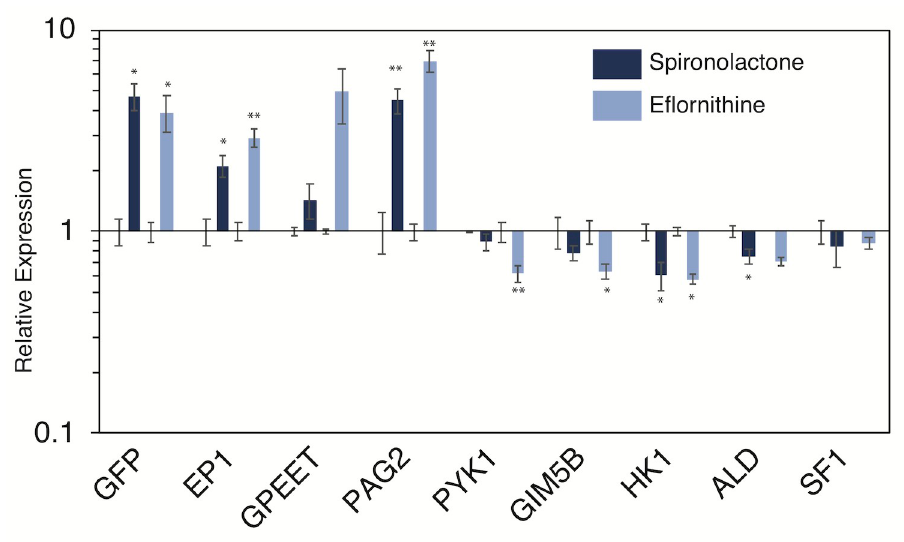
Fig 6. Treatment with spironolactone and eflornithine changes expression levels for a subset of differentiation associated genes. Q-PCR experiment showing relative expression levels for indicated genes in parasites treated for 3 days with 33 μ M spironolactone, eflornithine, or vehicle control. Error bars indicate standard error of 3 biological replicates. � , �� , ��� indicates p < 0.05, p < 0.01, and p < 0.001 respectively as measured by an unpaired, two-sided Student’s t-test. Note, relative expression is plotted on a log